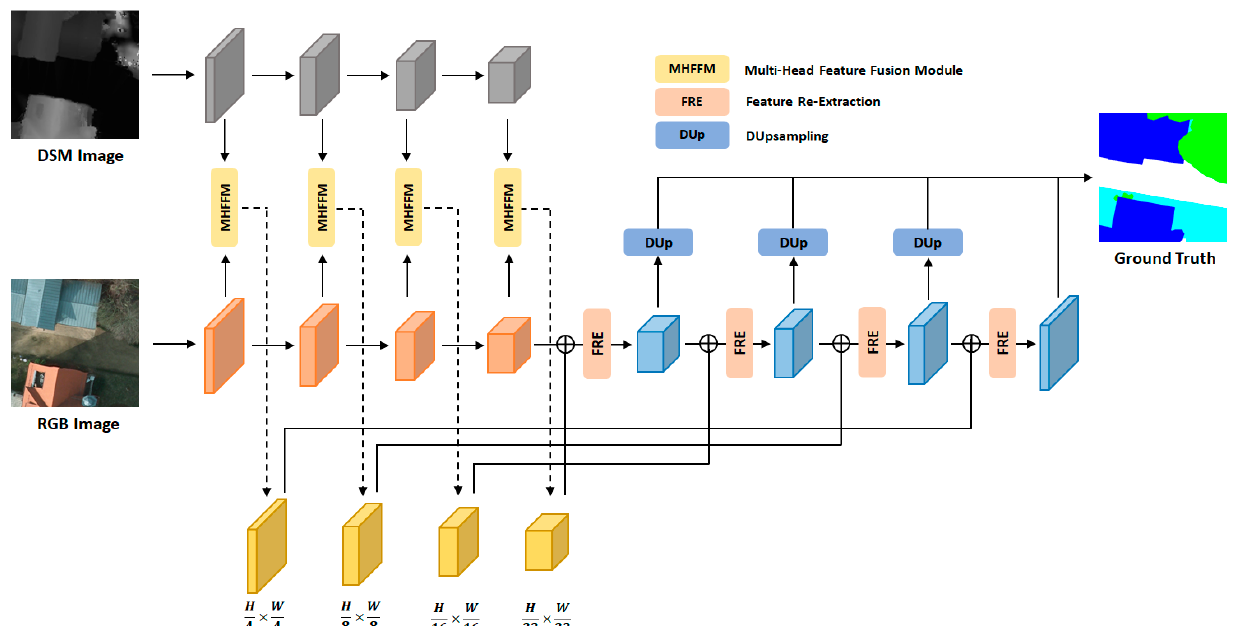
Figure 3. MFTransNet Overall Architecture.